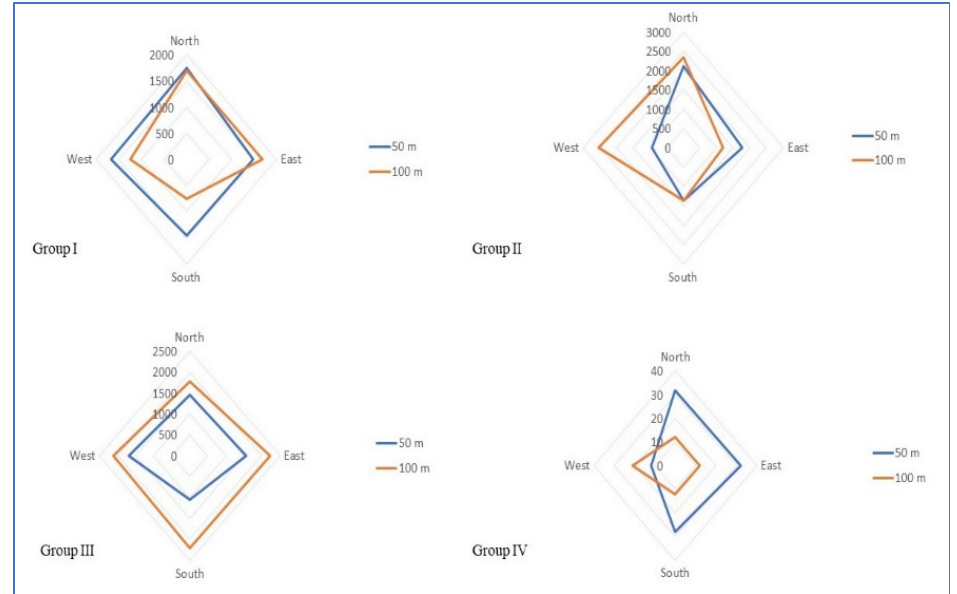
Figure 4. Radar chart showing magnetic field strength distribution around cell phone towers among different study groups .